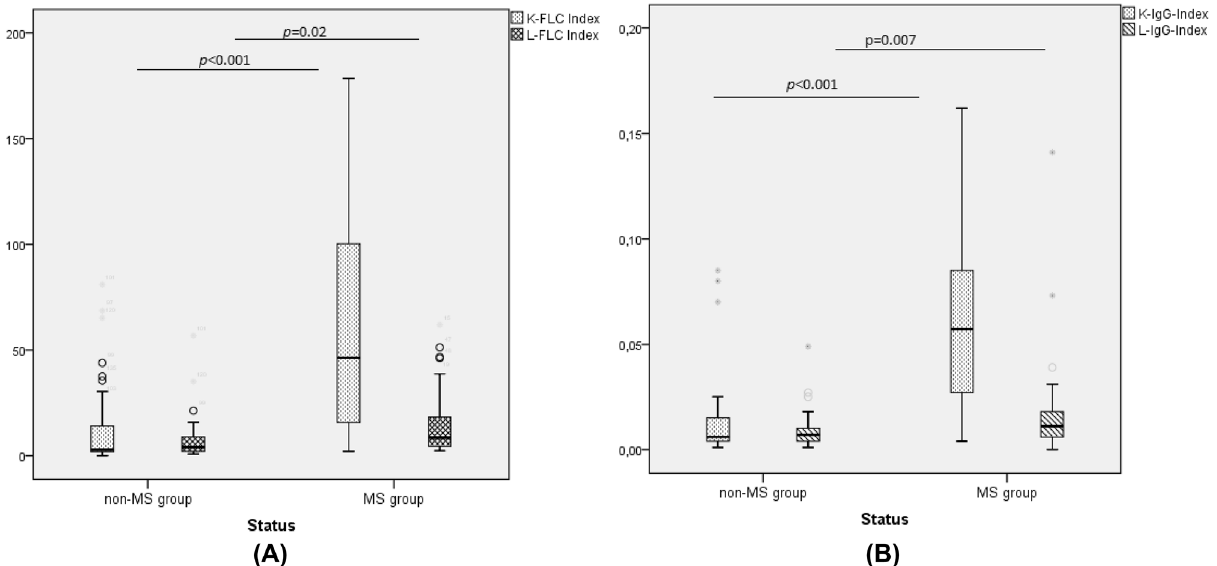
Figure 2. ( A ) Box plots showing the comparative distribution of κFLC index and λ FLC index in Multiple sclerosis (MS) and non-MS groups. ( B ) Comparative distribution (Box plots) of κ-IgG index and λ-IgG index in multiple sclerosis (MS) and non-MS groups (U test of Mann–Whitney). Horizontal solid lines indicate